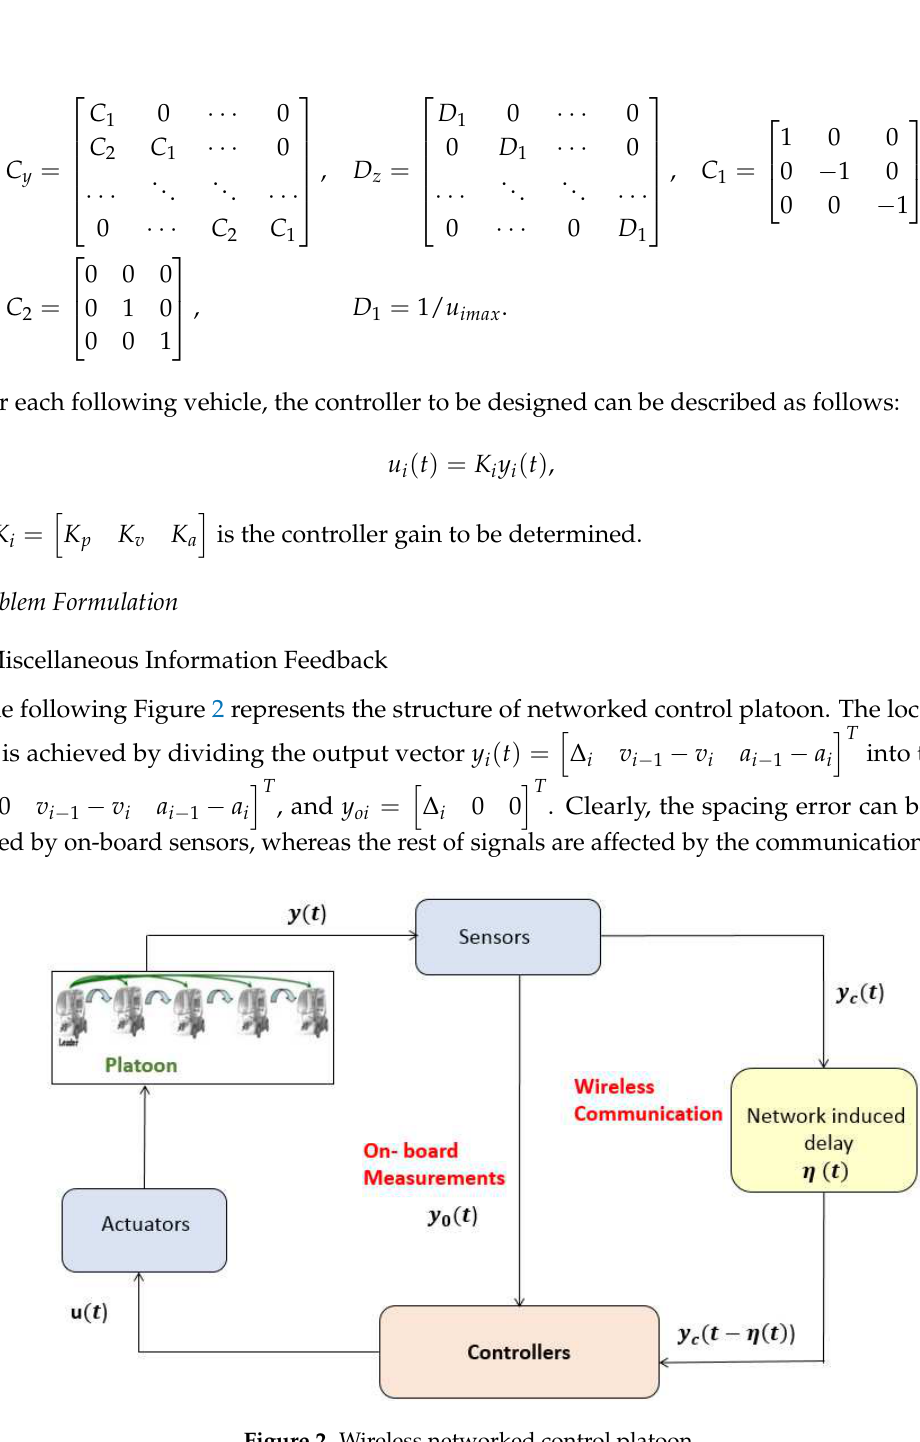
Figure 2. Wireless networked control